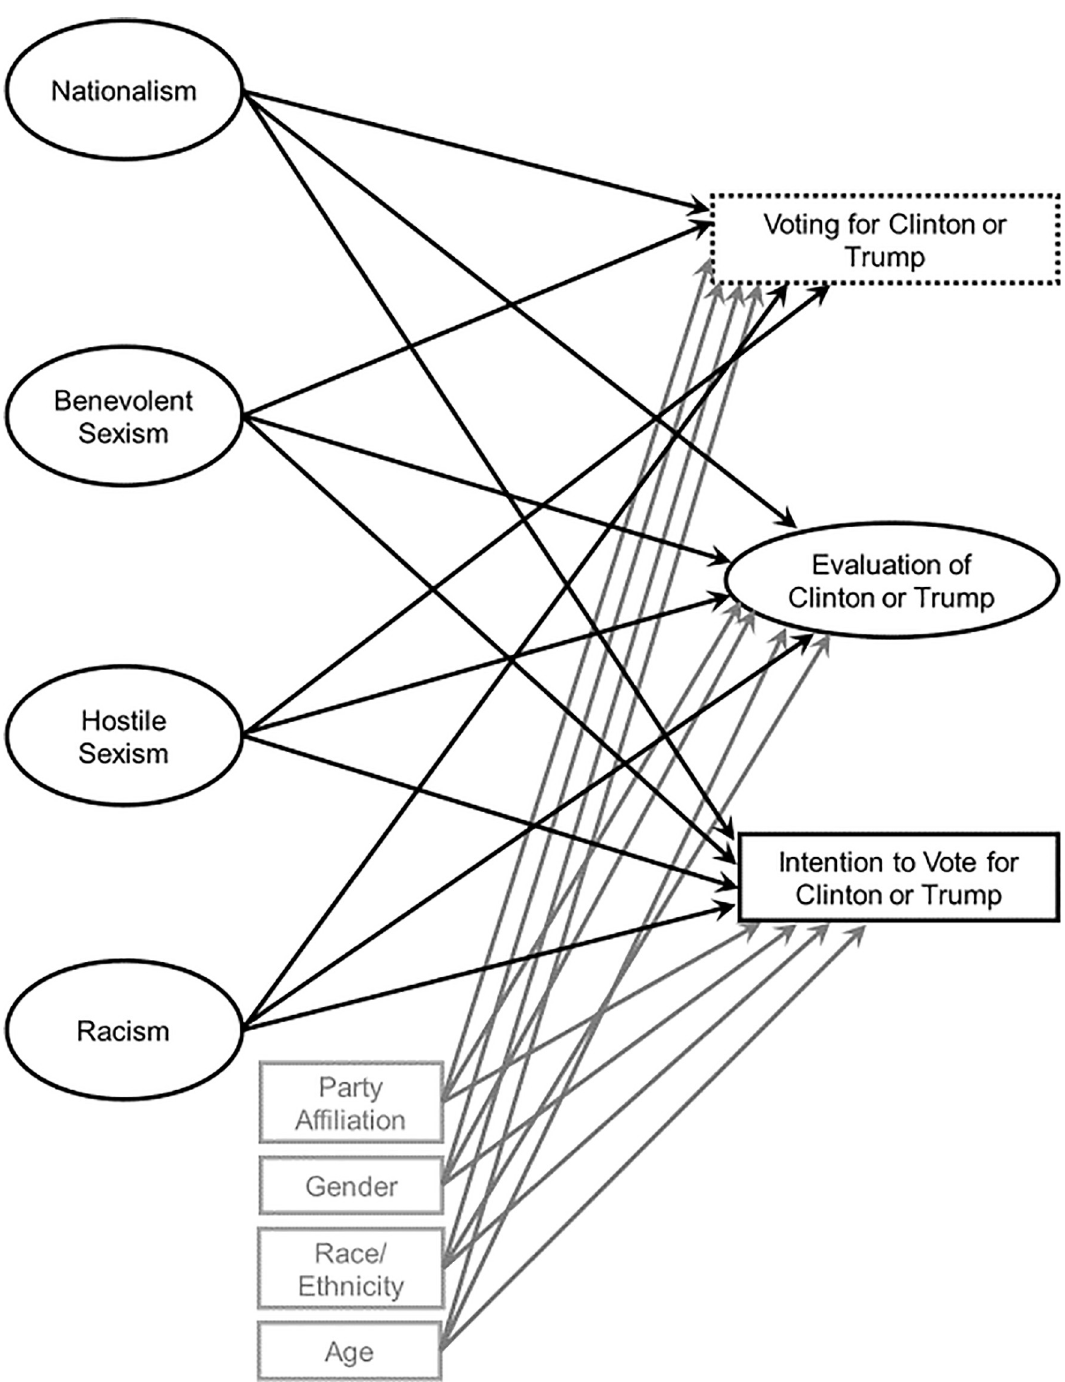
Fig 1. Conceptual figure depicting structural model testing the extent to which sexism toward women, modern racism, and nationalism were uniquely associated with evaluations of, intentions to vote for, and voting for Clinton or Trump. Separate models were tested for each candidate. Party affiliation, gender, race/ethnicity, and age were included as